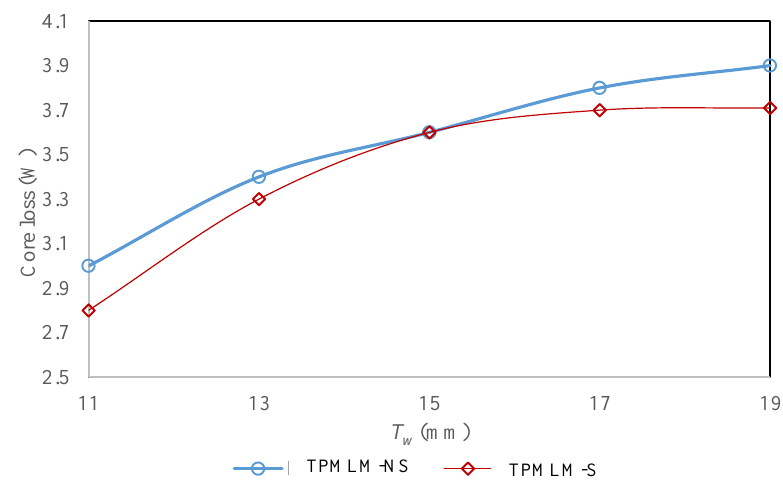
Figure 23. Influences of T w Variation on Core Loss.